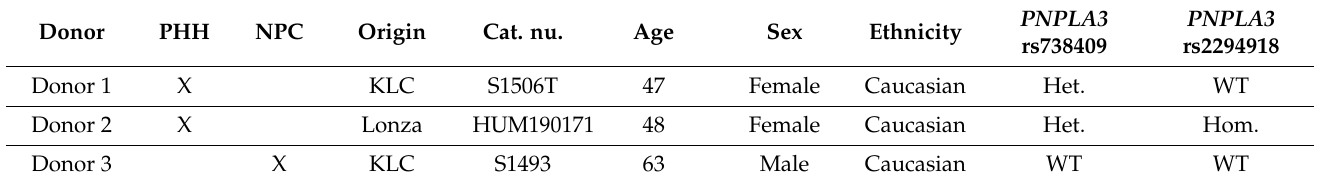
Table 1. Characteristics of primary human hepatocyte and non-parenchymal cell